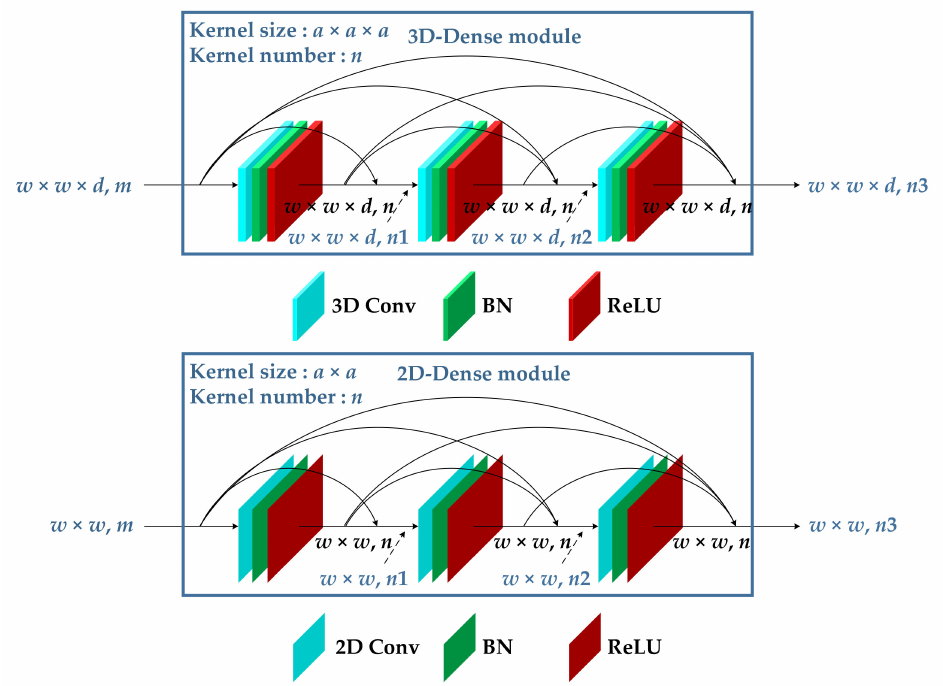
Figure 5. Structures of the dense module used in our study ( l = 3): ( a ) 3D-Dense module; ( b ) 2D-Dense